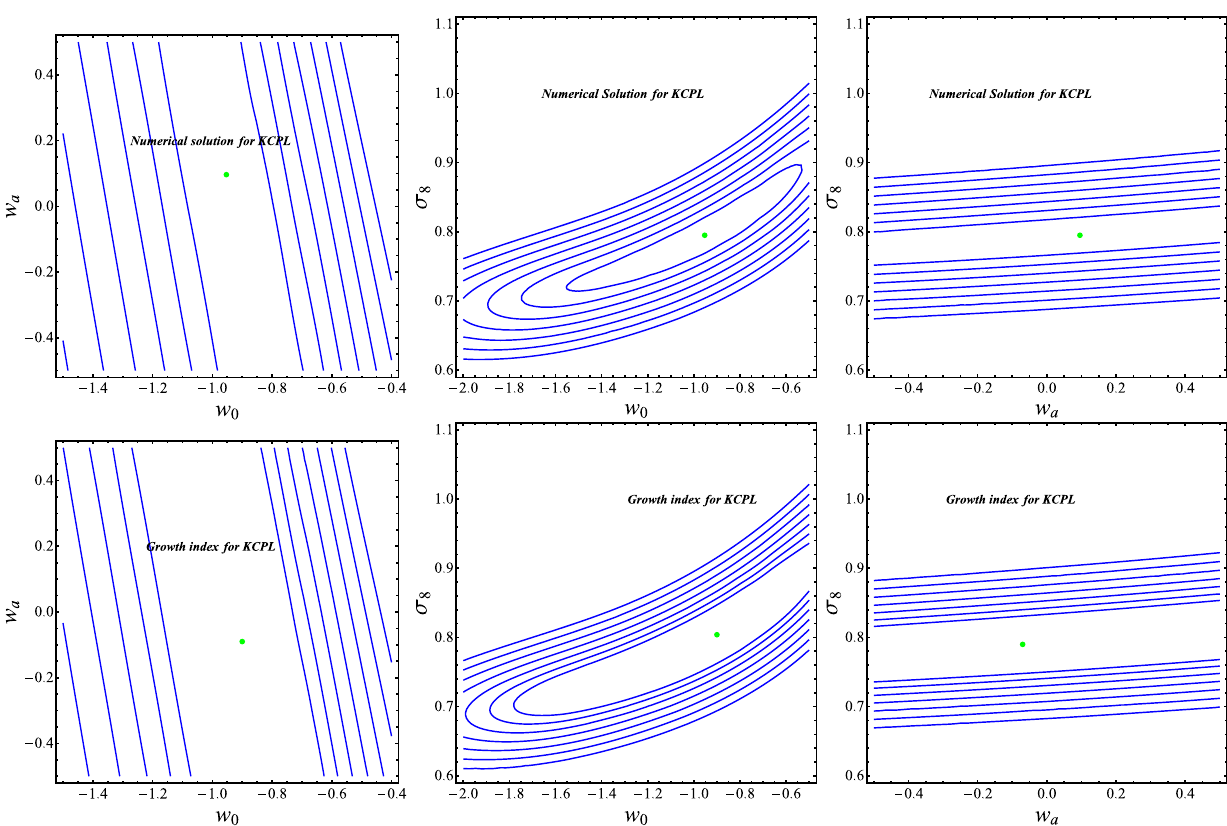
Fig. 4 In the top, we can see observational constraints on the model KCPL using numerical solution. In the bottom, we see the observational constraints using growth index. In all the figures we use the best fits for the parameters ( (cid:3) m 0 ,(cid:3) k 0 ,γ 0 ,γ a ) shown in Table